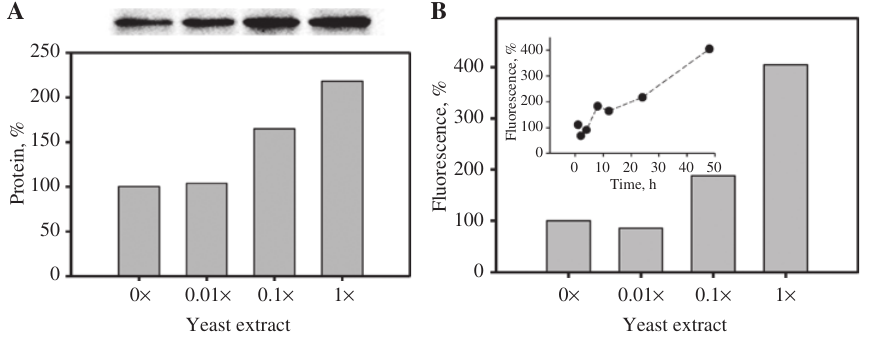
Figure 3: Effect of yeast extract on S349L. (A) Protein levels determined by Western blot assay. The images obtained from chemiluminescense reaction (shown above) were quanti- fied and plotted by percentage of the control (0 × yeast extract). Crude extracts equivalent to 50 μ g of total protein were used for each well. (B) Relative levels of fluorescence. Time-course of changes in fluorescence with 1 × yeast extract (inset). The transformed cells ( pah − [S349L] for Western blot and pah − [GFP-349L] for FACS analysis) were cultured in FM medium with the indicated amounts of yeast extract. 1 × yeast extract corresponds to 5 g per liter. The FACS data is representative of two independent